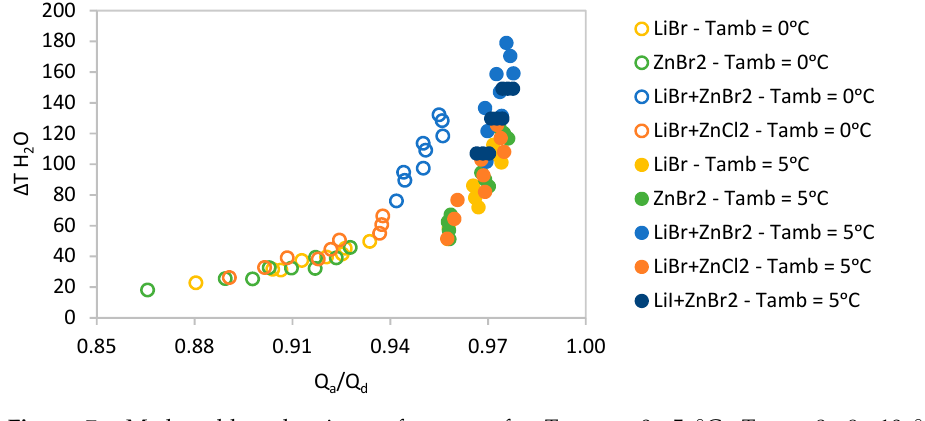
Figure 7. Methanol-based pairs performance for T amb = 0, 5 ◦ C, T a = 8, 9, 10 ◦ C and T d = 13, 14, 15 ◦ C .